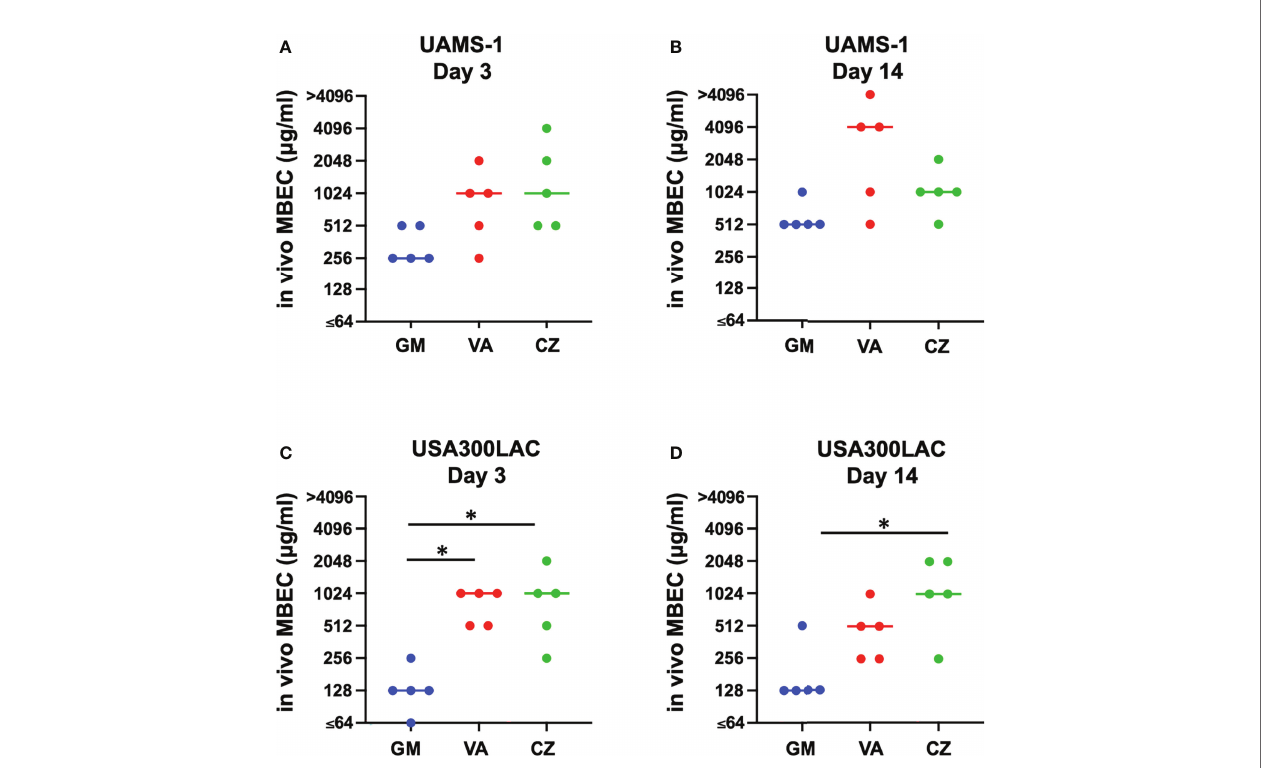
FIGURE 2 | Minimal bio fi lm eradication concentration of in vivo bio fi lm formed on the implant incubated in rat femur for 3 days and 14 days ( in vivo MBEC) of UAMS-1 (A, B) and USA300LAC (C, D) . Bars in each graph indicate the median of fi ve assays. *: p < 0.05 by Kruskal-Wallis test with Dunn ’ s multiple comparison. GM, gentamicin; VA, vancomycin; CZ, cefazolin.